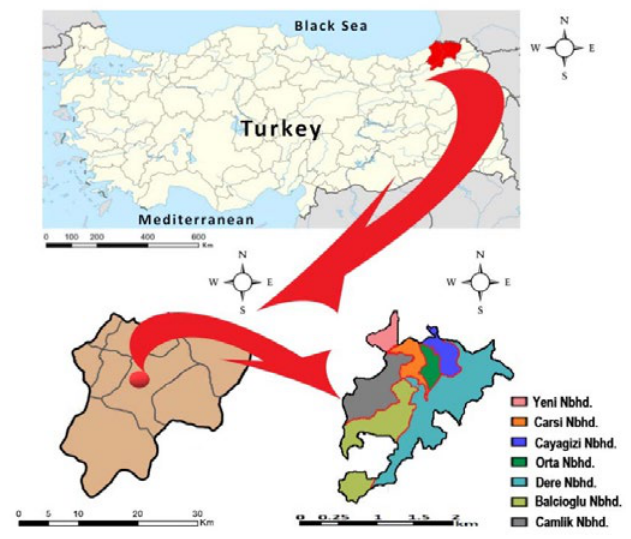
Fig. 1: Location of the study area